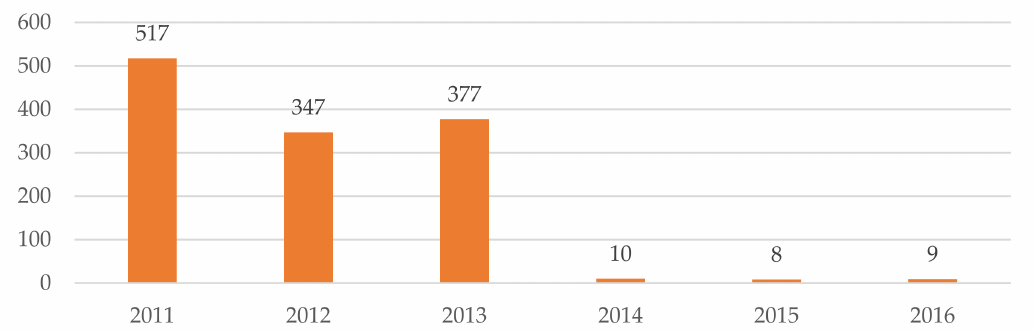
Figure 2. Amount of waste (in thousand tonnes) generated in Poland in the form of sugar beet pulp (more recent data is not available) Own elaboration based on: